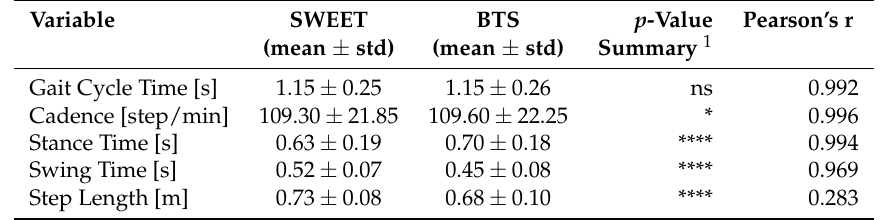
Table 3. Paired- T test.